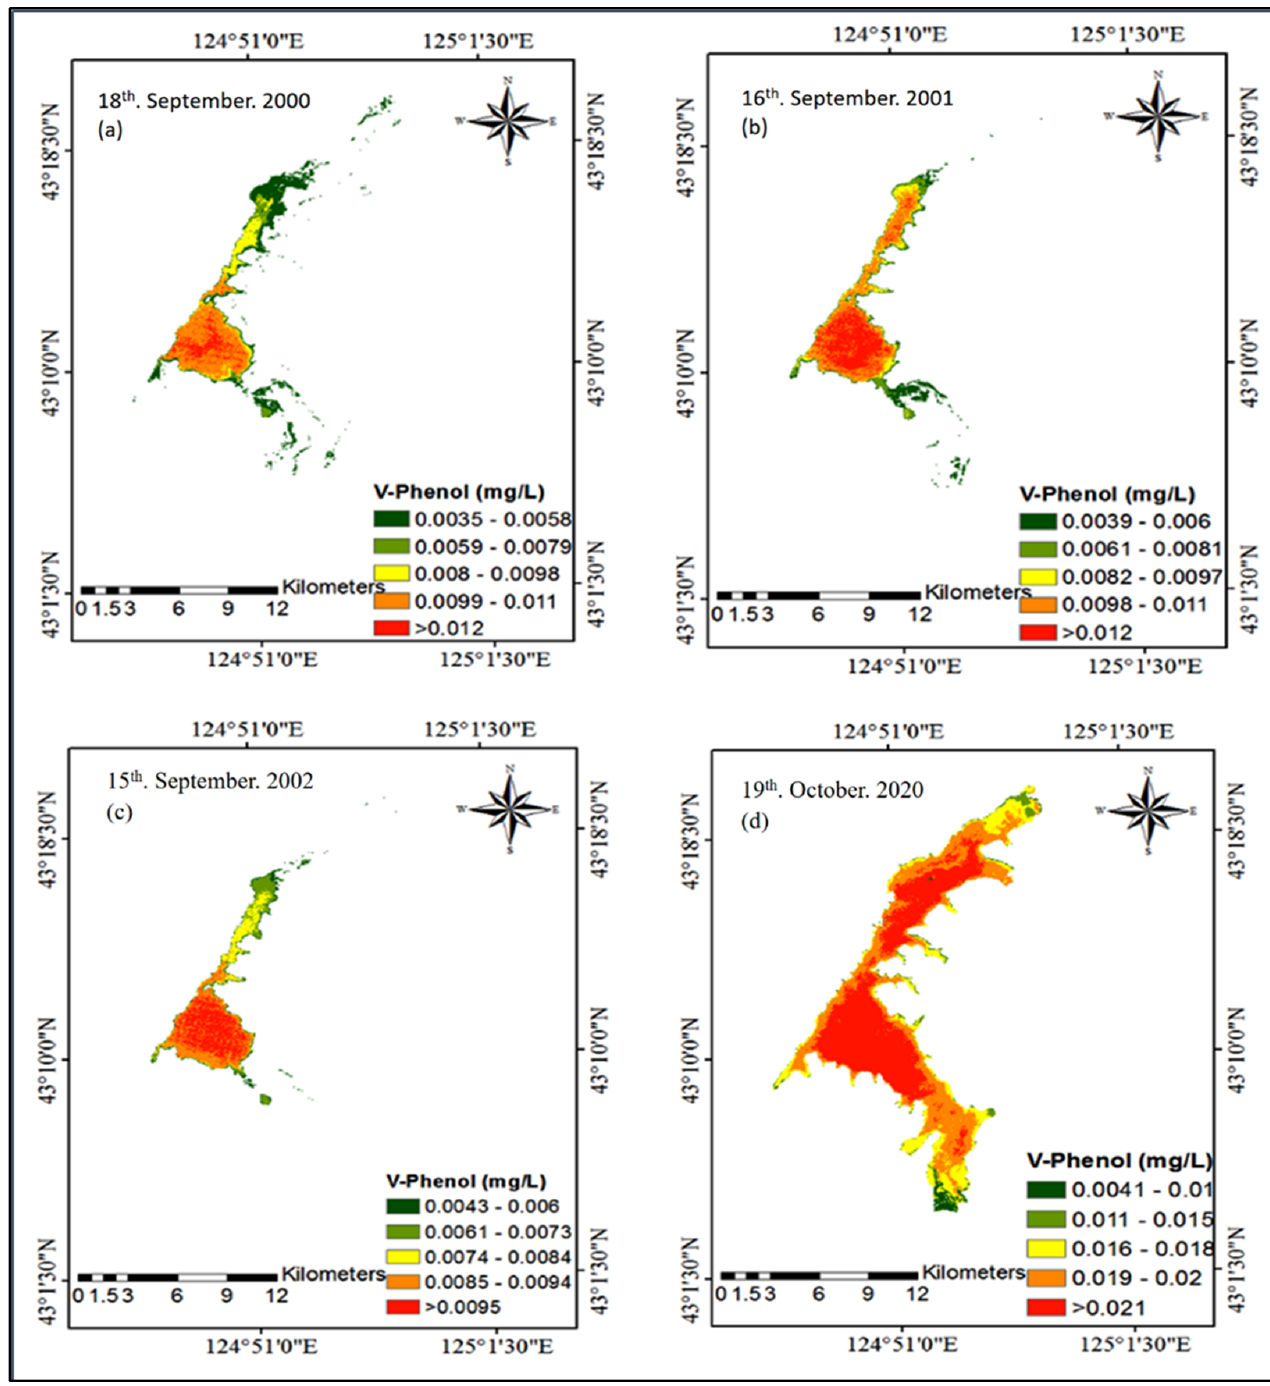
Figure 5. Spatial distributions of V-phenol (( a ) spatial distributions of V-phenol on 18 September 2000, ( b ) spatial distributions of V-phenol on 16 September 2001, ( c ) spatial distributions of V-phenol on 15 September 2002, ( d ) spatial distribution of V-phenol on 19 October 2020), estimated via models generated from Landsat (TM, ETM, and OLI8) in Erlong Lake.